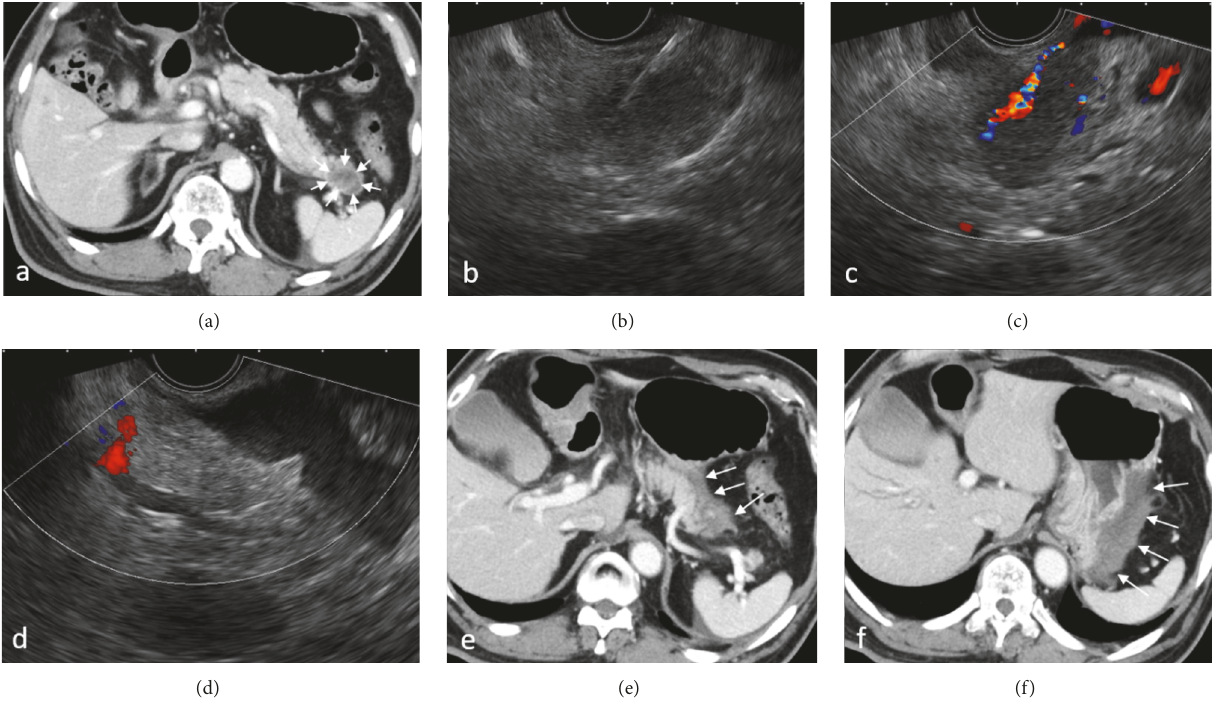
Figure 4: A patient who developed bleeding with endoscopic ultrasound-guided fine needle biopsy (EUS-FNB) using a Franseen needle. (a) Contrast-enhanced Computed Tomography (CT) scan showing a 3-cm hypovascular mass in the pancreatic tail (arrow). (b) Insertion of the needle under EUS guidance. (c) Active bleeding from the needle tract right was noticed under color Doppler mode after the withdrawal of the needle. (d) Increased echo-free space between the pancreas and stomach was identified. ((e), (f)) Contrast-enhanced CT scan was performed immediately after EUS-FNB. Hyperdense fluid collection suggesting hematoma was observed between the pancreatic tail and the greater curvature of the stomach